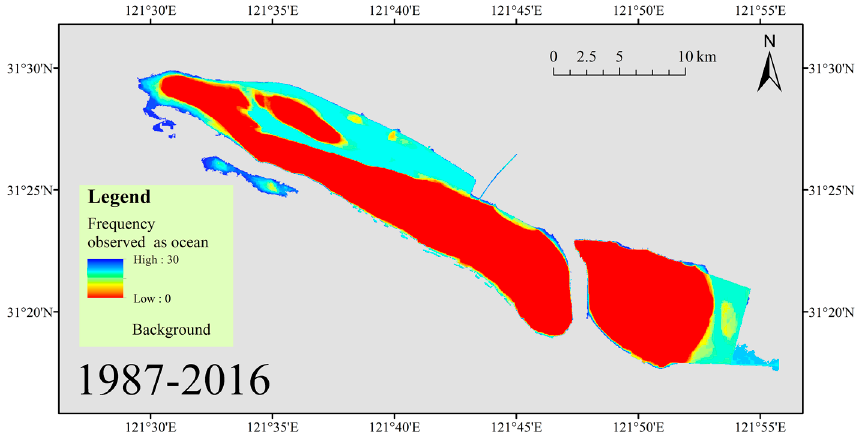
Figure 7. Spatial distribution of the frequency observed as ocean for the estuarine islands in the period of 1987–2016 with a resolution of 30 m. Background represents the permanent ocean area.